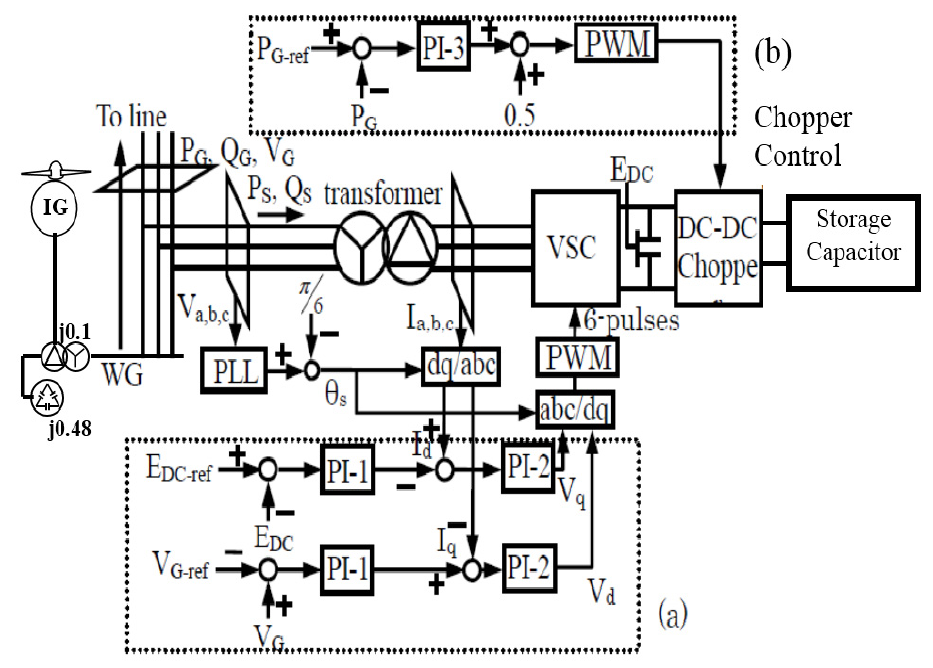
Figure 5. Wind farm B frequency control strategy ( a ) ECS control scheme ( b ) Chopper control.